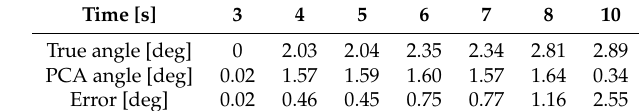
Figure 11. Pictures of the deployed drifter with the self-made INS in the test tank ( a )) and at sea ( b )). Table 1. Directional angles recorded from the sea experiments.